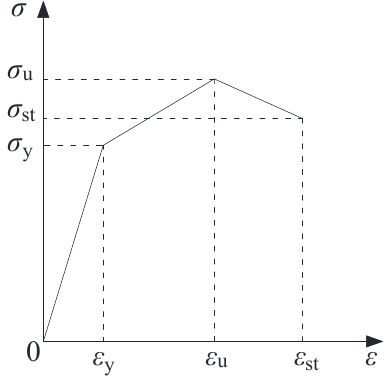
Figure 4. The constitutive relation of steel in the FEM model.